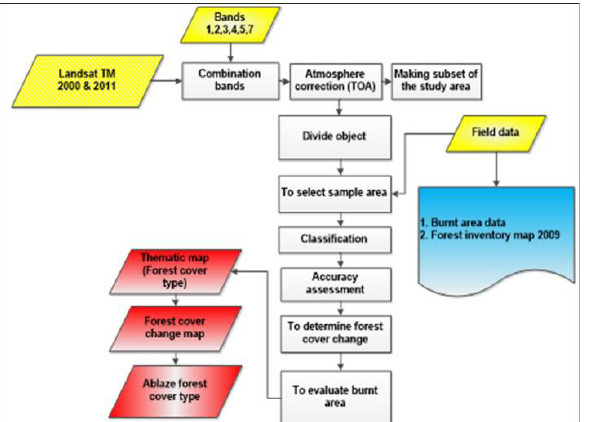
Figure 3. Diagram of the methodological workflows